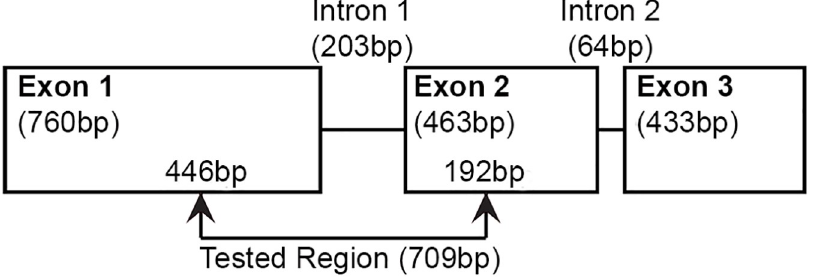
Fig 3. CCEae3a gene structure. CCEae3a consists of three exons and two introns, representedby boxes and lines respectively,with their size in base pairs (bp). The regionselectedfor the phylogenetic analysisis indicatedby the